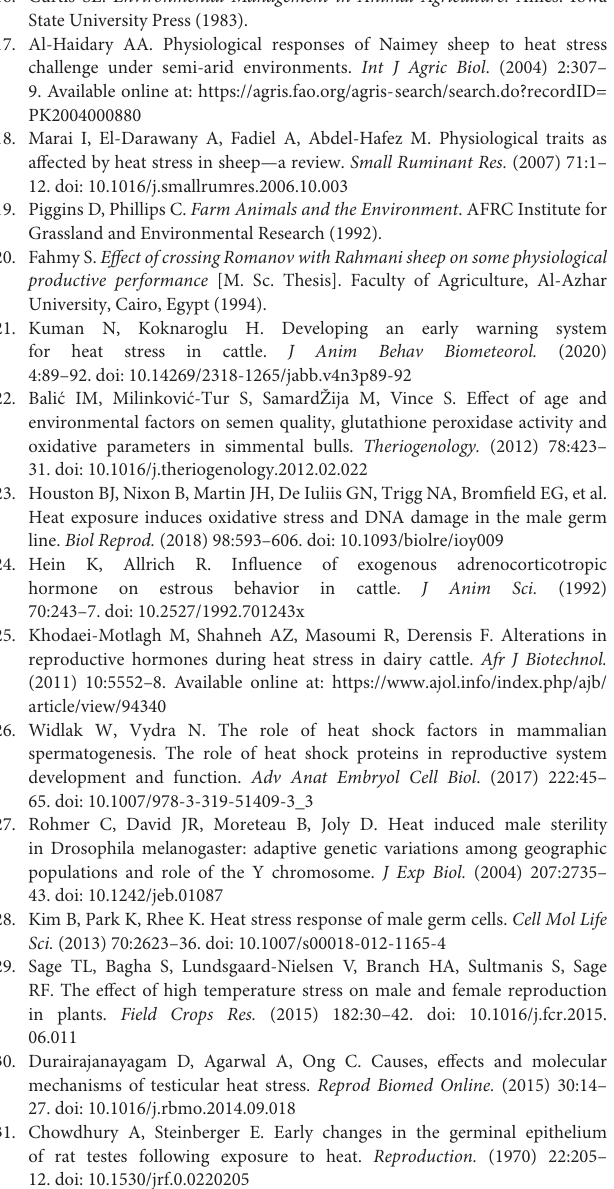
Supplementary Figure 1 | Changes in temperature in different parts of the body during heat stress. (A) Head, (B) ear, (C) abdomen, and (D) rectum. Supplementary Figure 2 | Analysis of spermatozoa number in spermatogenic tubules after HS. (A) SOX9 (green fluorescence) labeled supporting cells, PNA (red fluorescence) labeled sperm, and DAPI (blue fluorescence) labeled nucleus. (B) Spermatozoa in 500 sertoli cells. Scale = 50 µ m, significance was calculated by T -test, ∗∗ means P < 0.01.